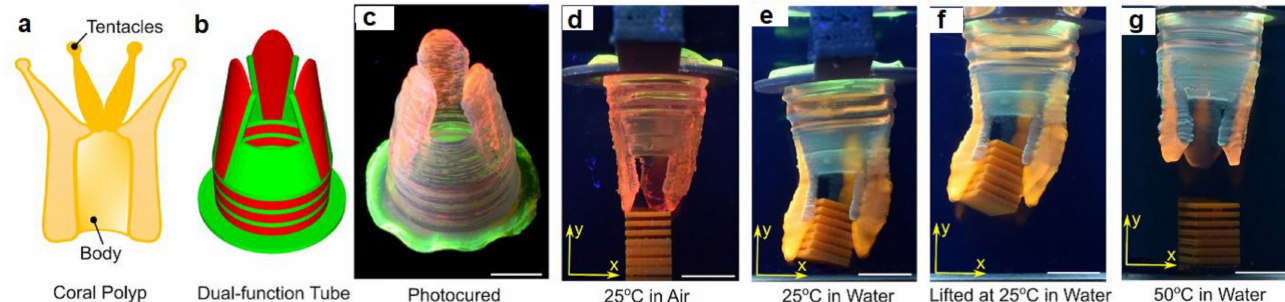
Figure 18. Dual-shape change tubes. ( a ) Scheme of the fundamental coral polyp anatomy; the picture was produced from encyclopedia polyp representations. ( b , c ) CAD model and 3D picture with cylindrical base, three fingers printed, and photo-cured tube. ( d – g ) Optical tube shapes alter at various temperatures. The tube has been suspended in a tank over a section. The tube displays uniaxial elongation and grasping of the portion when water was added to the tank. The tube shortened, and the fingers opened when heated to 50 ◦ C to unload the component back down to the bottom of the tank. Scale bars are 1 cm. Copyright 2019 ACS. Reprinted with permission from ref. [330].